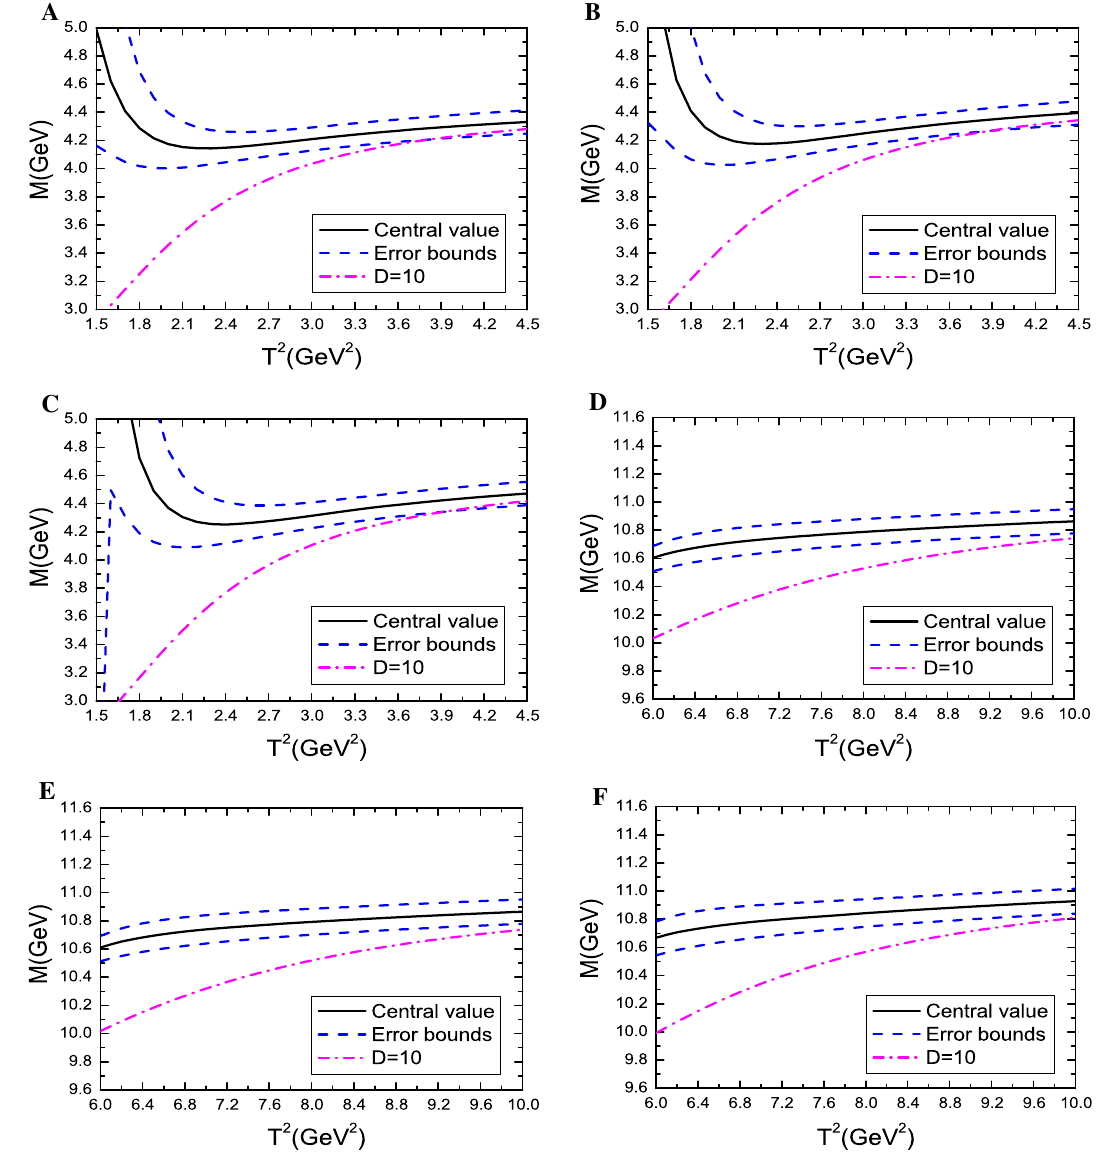
Fig. 5 The masses of the doubly heavy pentaquark states with vari- the D = 10 denotesthepredictionsbasedonthetruncationsoftheoper- ations of the Borel parameters T 2 , where the A , B , C , D , E and F ator product expansion up to the vacuum condensates of dimension denote the P , P , P , P , P and P , respectively, cc , 1 2 cc , 3 2 bb , 1 2 bb , 3 2 cc , 5 2 bb , 5 2